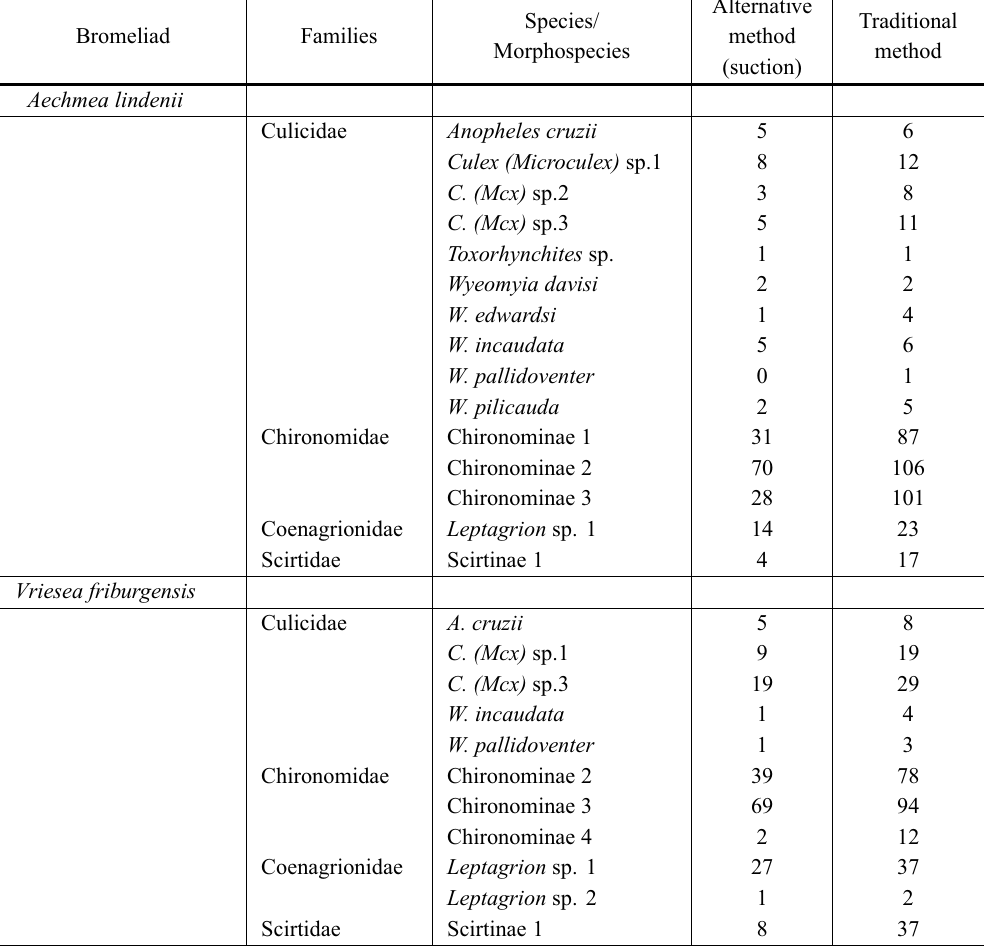
Species/Morphospecies of Culicidae, Chironomidae, Coenagrionidae and Scirtidae collected from Aechmea lindenii and Vriesea friburgensis by the alternative and traditional method in a restinga area at Florianópolis, SC, Brazil.